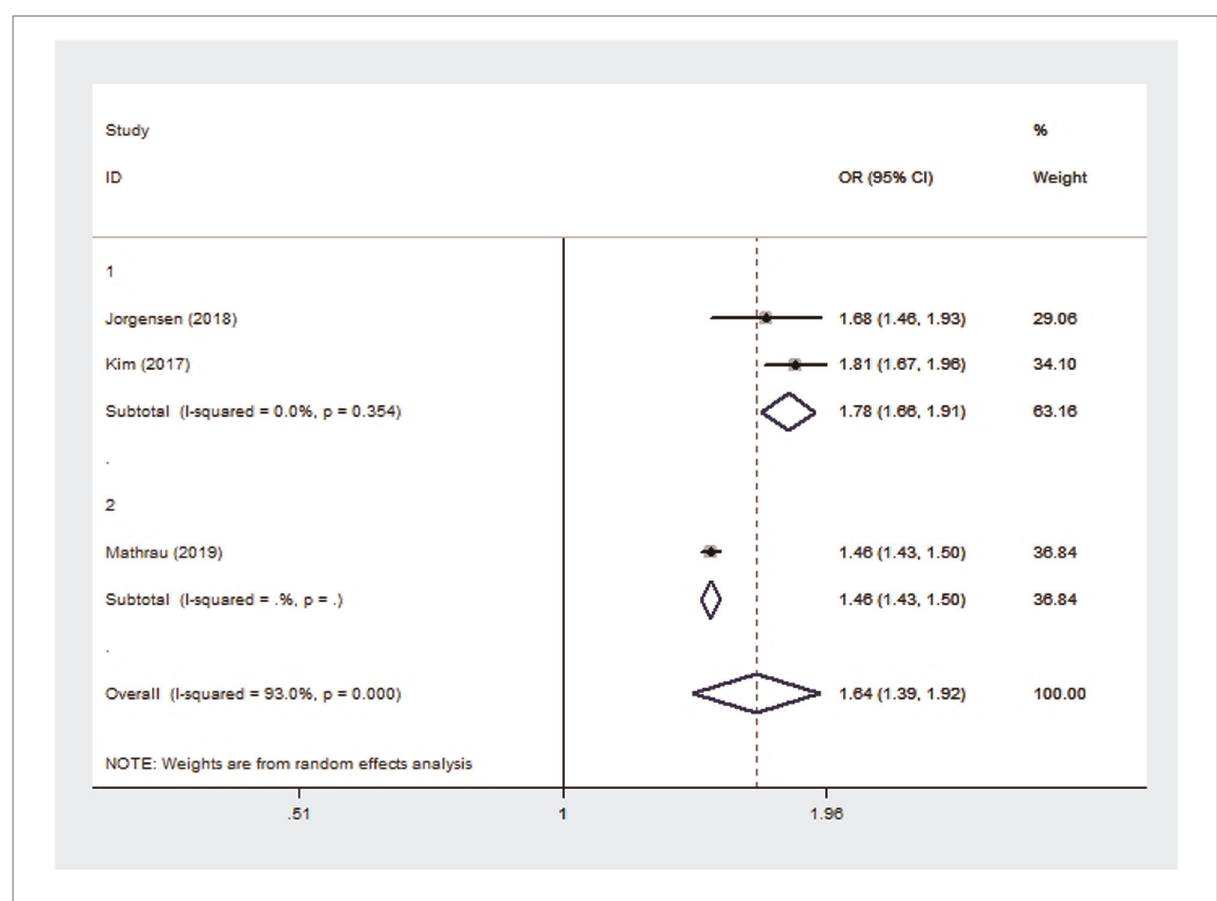
FIGURE 10 Forest plot of subgroup analysis for persistent opioid consumption based on study type (1: case-control study; 2: cohort